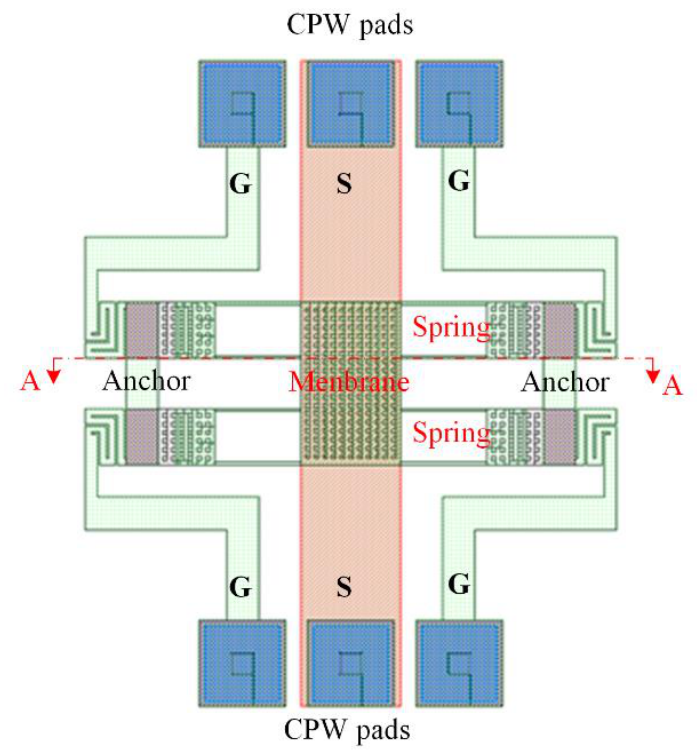
Figure 1. Microelectromechanical system switch (MSS) structure. The radio frequency capacitive MSS provides high isolation at resonant frequency in the off state. The resonant frequency ( f 0 ) can be expressed as [9],